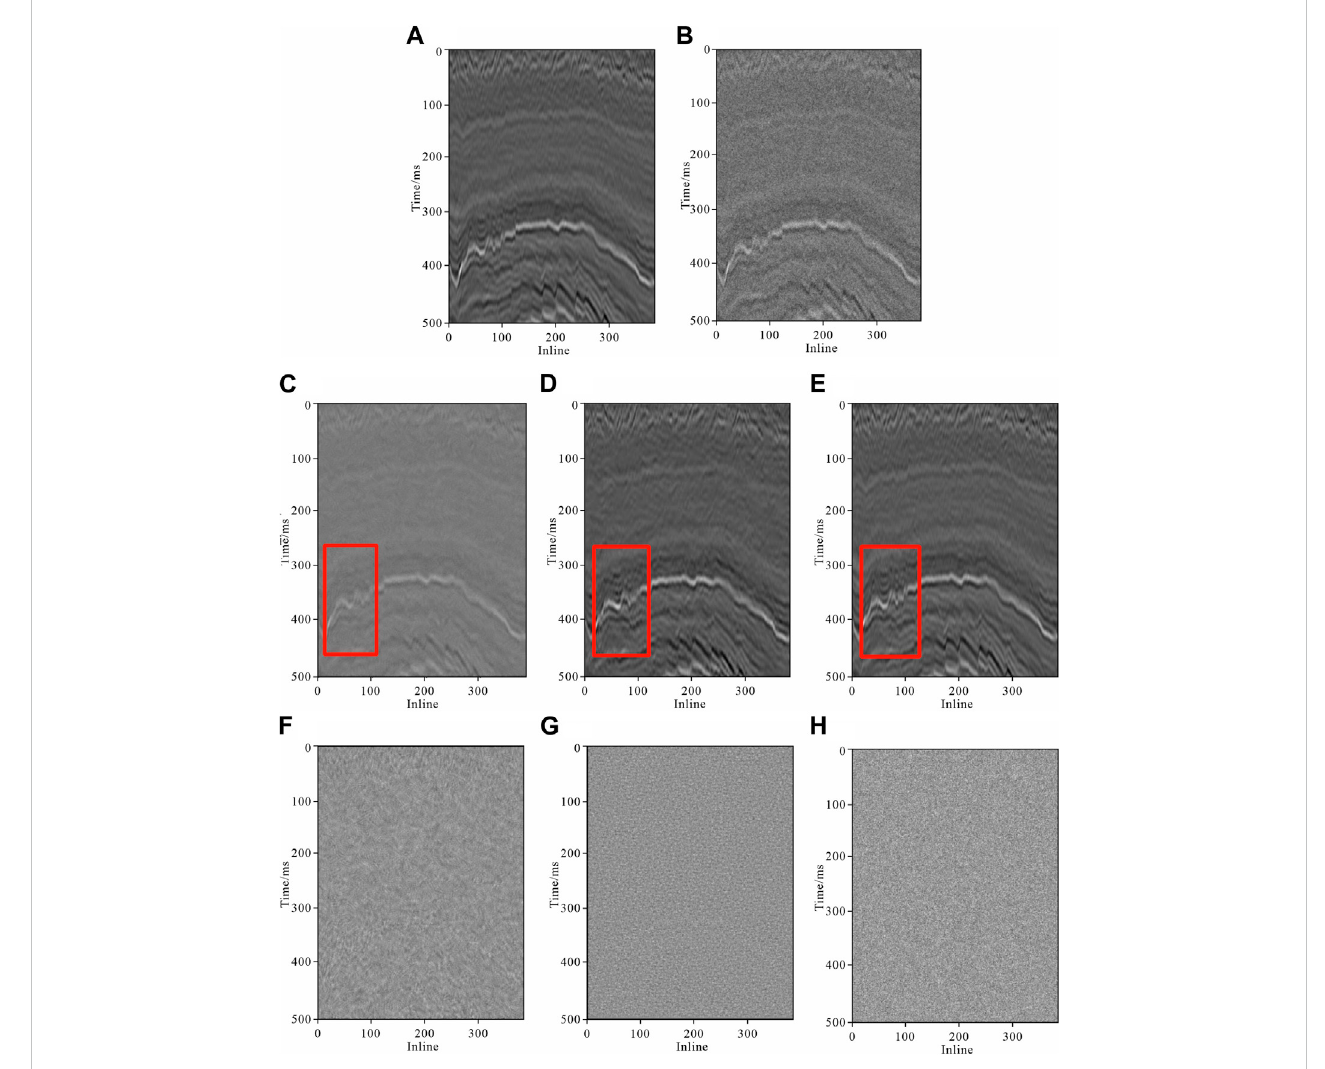
FIGURE 11 Experimental results for the real seismic data. (A) Real seismic data, (B) real seismic data with random noise, (C) denoising effect of FX deconvolution method, (D) denoisingeffectoftheoriginalCycleGANmethod, (E) denoisingeffectoftheimprovedCycleGANmethod, (F) noiseremovalbyFXdeconvolution method, (G) noise removal by the original CycleGAN method, and (H) noise removal by the improved CycleGAN method developed herein.